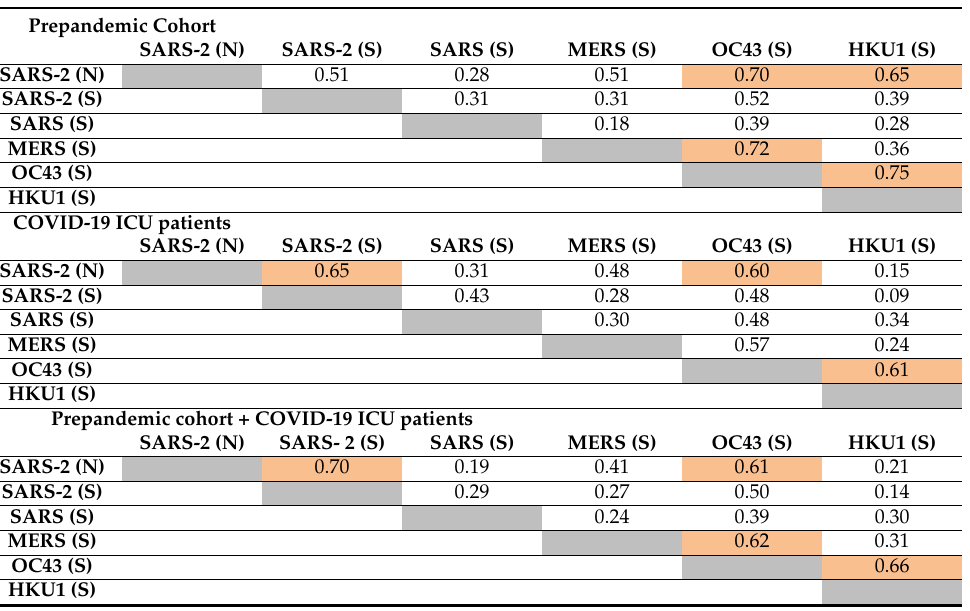
Table 1. Correlation coefficients for IgG against different betacoronaviruses in the prepandemic (n = 70), COVID-19 ICU (n = 86), and integrated prepandemic + COVID-19 ICU (n = 156) cohorts. The color marks cells with a significant level of correlation coefficients for IgG against different